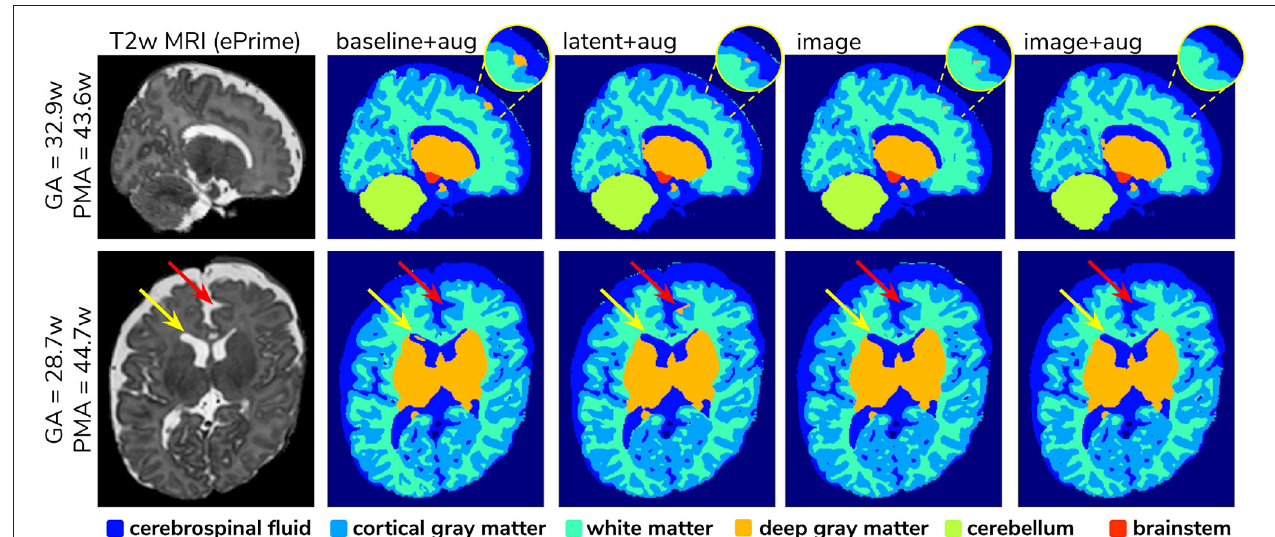
FIGURE 9 | Example predicted segmentation maps for the best performing models. On the first row we show an example where three of the models ( baseline with augmentation , latent with augmentation , and image ) misclassified a part of the cortex as being deep gray matter. This is more pronounced in the baseline with augmentation model, while the latent with augmentation and image show a slight improvement. The image with augmentation model corrected the problem entirely. On the second row the yellow arrow points to an area of CSF where the baseline with augmentation model misclassified it as dGM, while the other three models did not have this problem. The red arrow on the other hand points to an area where the latent with augmentation model misclassified cGM as deep gray matter. This problem does not appear in the other models.